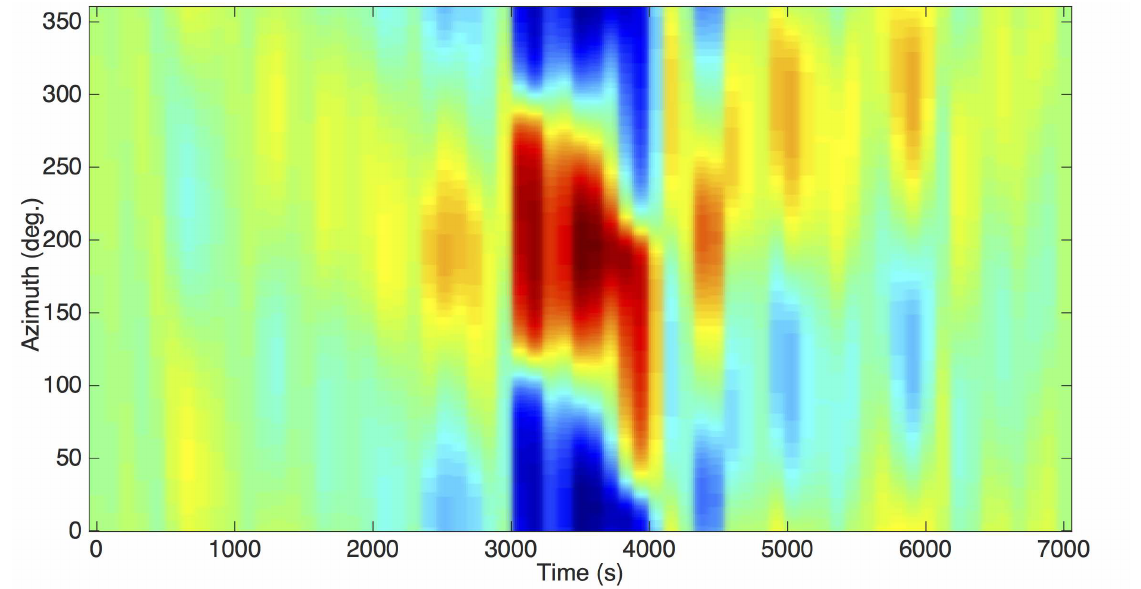
Figure 5: Zero-lag normalized correlation coefficient (defined between -1 (blue) and 1 (red)) between rotation rate and transverse acceleration, varying the unknown transverse direction from 0 ◦ to 360 ◦ . The theoretical propagation azimuth is 202 ◦